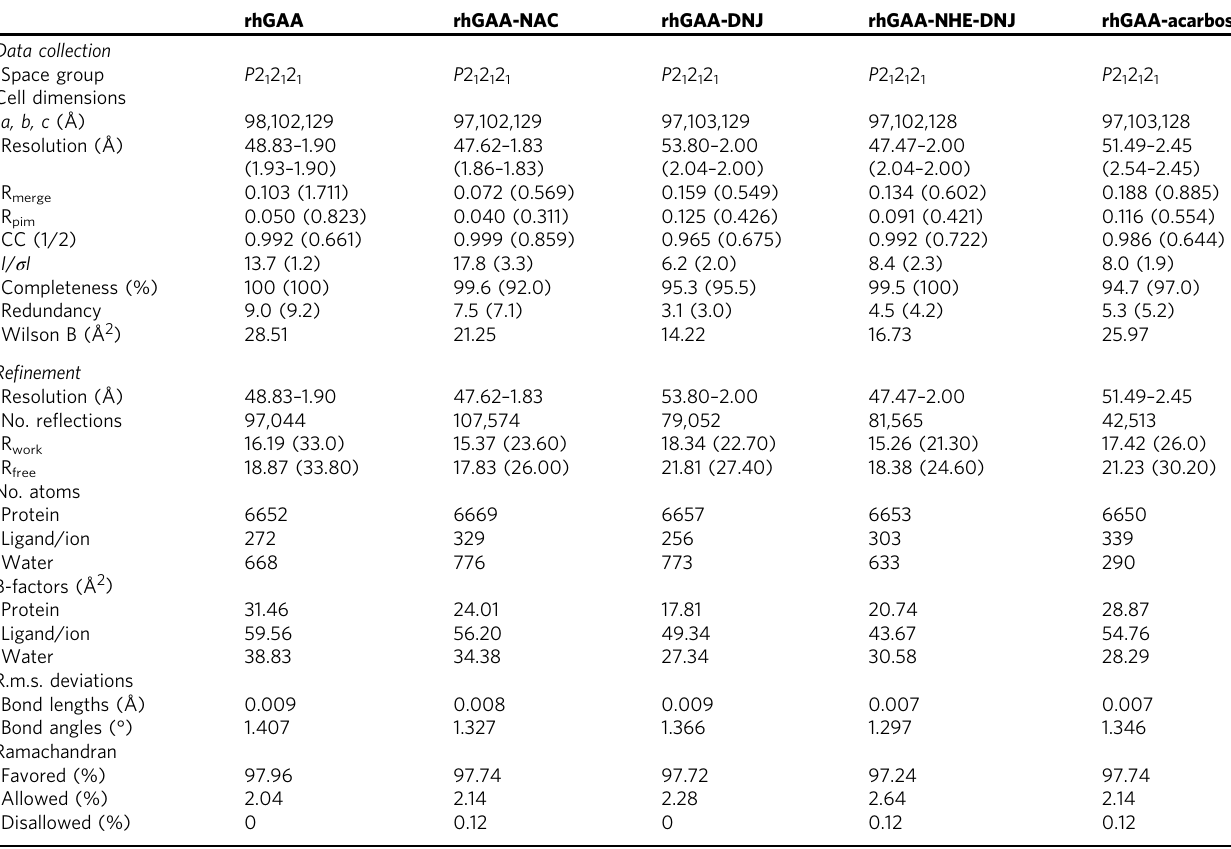
Table 1 Data collection and re fi nement statistics (molecular replacement) a, b